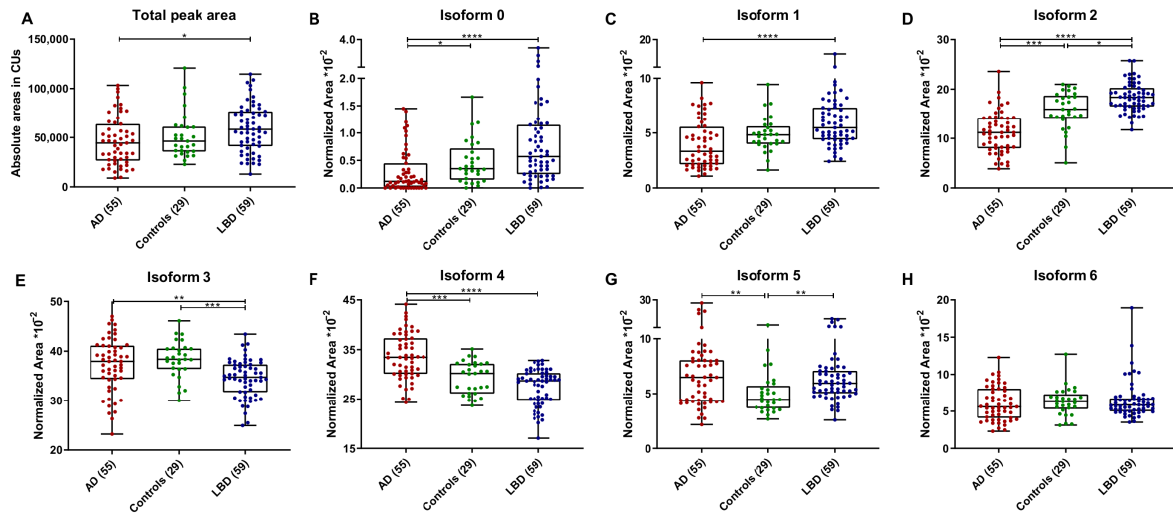
Figure 2. SerpinA1 isoform expression in AD, controls and LBD. ( A ) Comparison of total absolute peak areas among diagnostic groups (AD: Alzheimer’s disease, n = 55; Controls, n = 29; LBD: Lewy body disorders, n = 59), expressed in chemiluminescence units (CUs). ( B – H ) Relative expression of isoforms 0–6, reported as a percentage (normalized area *10 − 2 ). Box plots indicate median value, interquartile range and range of values. * p < 0.05, ** p < 0.01, *** p < 0.001, **** p <